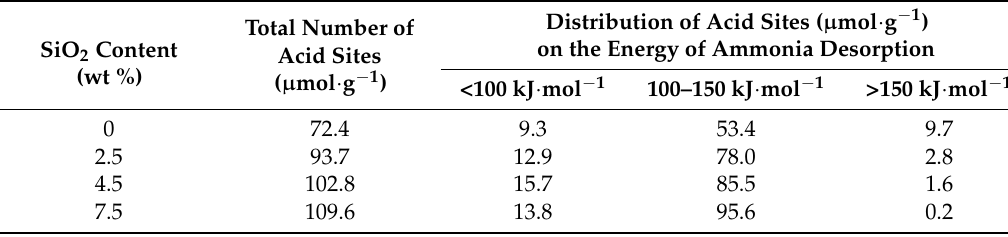
Table 6. Results from NH 3 -TPD measurement of catalysts.